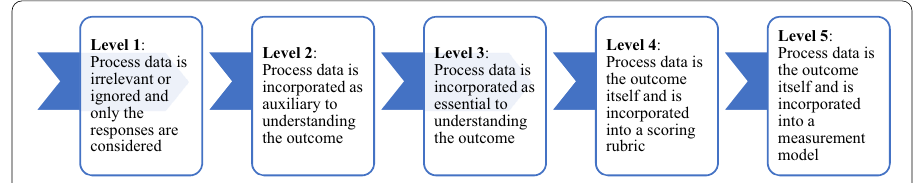
Fig. 1 Framework of process data uses in NAEP (Bergner and von Davier